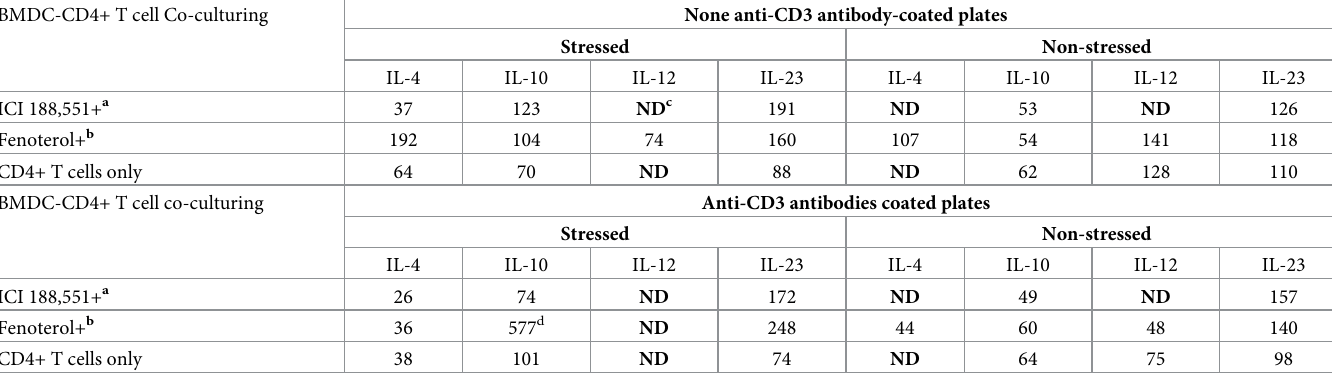
Table 5. Effect of β 2-AR agonist or β 2-AR antagonist on the production of Th1 and Th2 cytokines by CD4+ T cells of stressed/non-stressed mice co-cultured with BMDCs on plates with/without anti-CD3 antibodies. Data are representative of two or more independent experiments performed on different dates. BMDC-CD4+ T cell